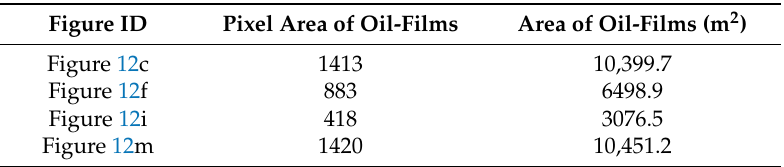
Figure 14. Data samples of pre-processed images. ( a – d ) Pre-processed images of Figure 3. Table 2. The area of identified